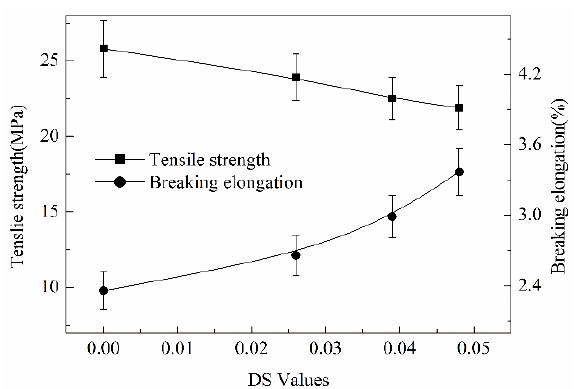
Figure 6. Influence of quaternization/hydroxypropylsulfonation on tensile properties of OTS films.